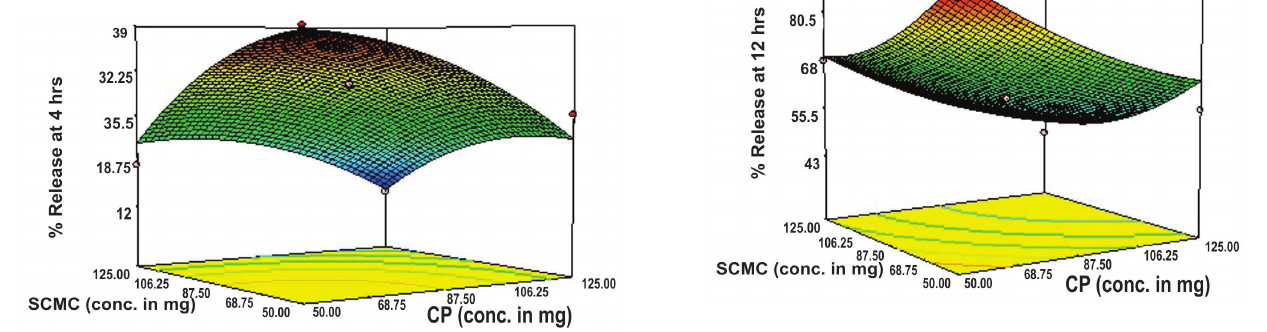
FIGURE 8 - Response surface plots showing the influence of CP and SCMC on the rel value of mucoadhesive tablet 12hrs formulations of flurbiprofen.